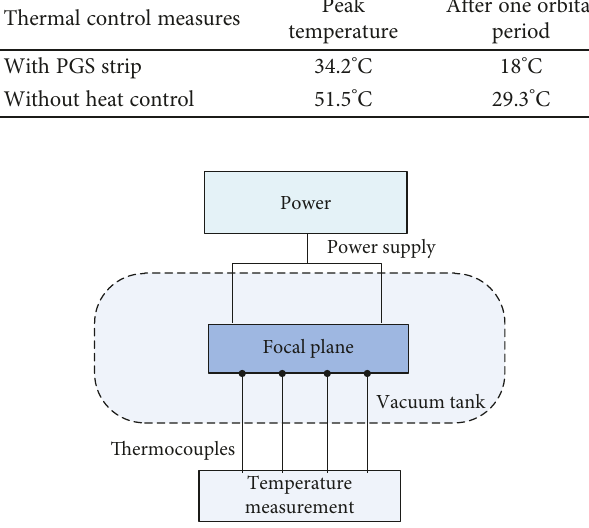
Figure 13: Test schematic diagram.